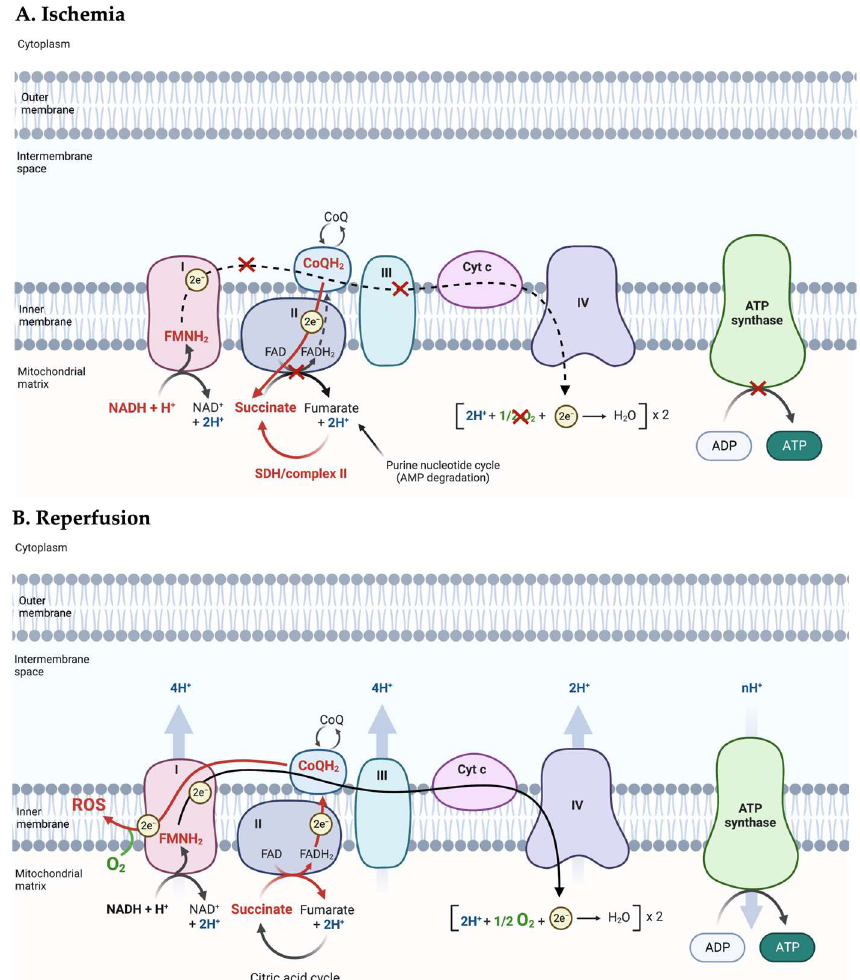
Figure 2. Mechanism of mitochondrial ROS production in renal ischemia–reperfusion injury. In normoxic conditions, the forward electron transport (FET) chain transfers electrons from NADH and FADH 2 to oxygen, the final electron acceptor, through a series of redox reactions. These reactions enable the proton pumps (complex I, III, IV) to build up a H + gradient which will drive the ATP synthase (complex V) to generate ATP through H + backflow. During ischemia, FET is interrupted due to the absence of oxygen leading to maximal reduction of the electron donors and carriers (e.g., FMNH 2 , CoQH 2 , NADH, FADH 2 ) and accumulation of succinate. During early reperfusion, the accumulated succinate is rapidly oxidized to fumarate, generating too much ubiquinol (QH 2 ) which impairs FET and favors reversed electron transport (RET) to flavin mononucleotide (FMN). Reduced FMN (FMNH 2 ,) is the direct source of ROS production at complex I (superoxide). CoQ, coenzyme Q or ubiquinone; Cyt C, cytochrome C; FAD, flavin adenine dinucleotide; FMN, flavin mononucleotide; NAD, nicotinamide adenine dinucleotide; SDH, succinate dehydrogenase. Black lines indicate FET; red lines indicate RET.